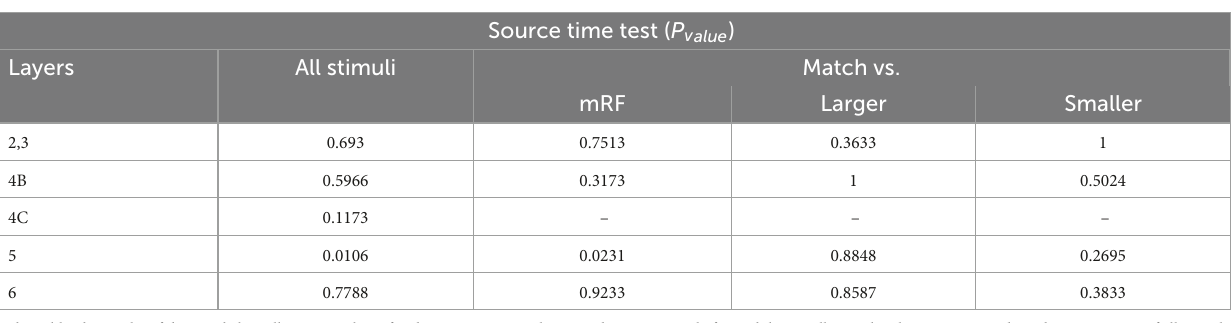
TABLE 2 The statistical test in each layer for source time analysis.